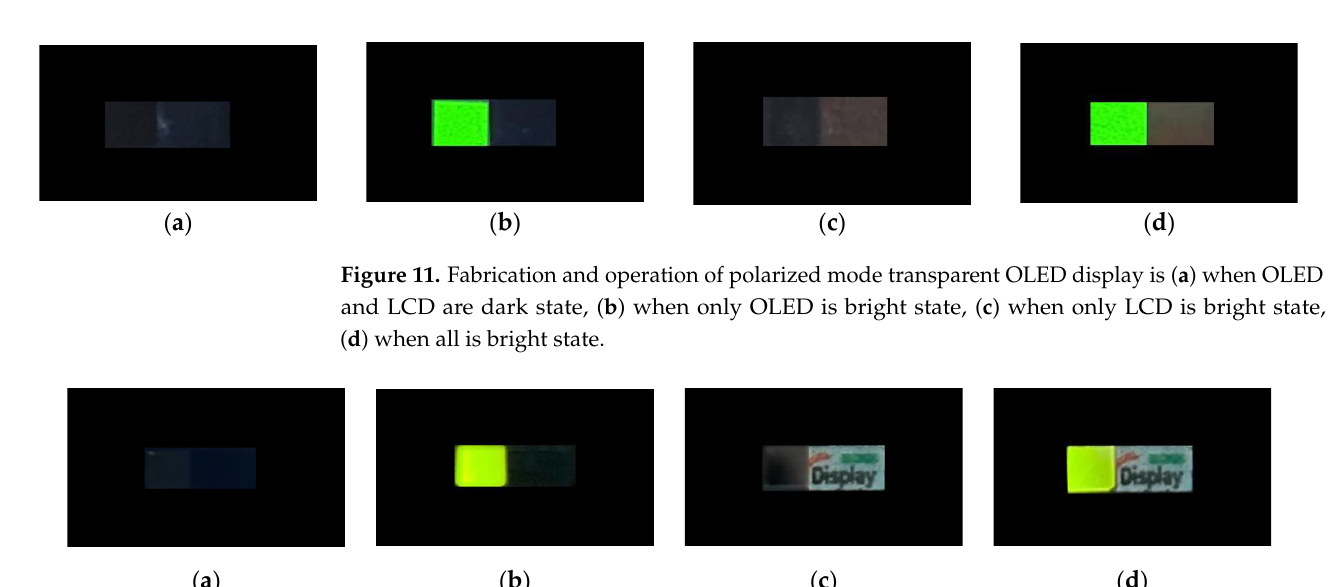
( b ) Figure 10. (a) OLED The OLED cell structure used , (b) Chemical structures of materials applied to OLED . In order to realize the proposed transparent OLED cell, an ITO electrode coated on the glass was simultaneously patterned for the OLED part and the LCD part in the cell. The ratio of the window part and the display image part was 1:1, and the cell gap of the LC was adjusted using a column spacer. In order to prevent leakage of the LC to OLED device area, a wall using sealant was fabricated, and we applied a bottom emission OLED type for the proposed hybrid-type transparent OLED display. First of all, the ITO was patterned using positive photoresist (AZ GXR-601, 14 cP, AZ Electronics Materials Co., Ltd., Tokyo, Japan) to fabricate the proposed cell. The bottom glass was patterned to realize the OLED part, and the top glass was patterned so that LC and OLED do not overlap. We have especially applied bottom emission type OLED struc- ture because a cathode of the OLED reflects 100% of the emitted light so that it is never disturbed by the material on the top electrode when emitting light. Then polyimide (RN- 1322, Nissan Chemical, Chouku, Japan) was coated on the bottom and top glass to coat the alignment layer, and photo rubbing was performed using ultraviolet ray (1200